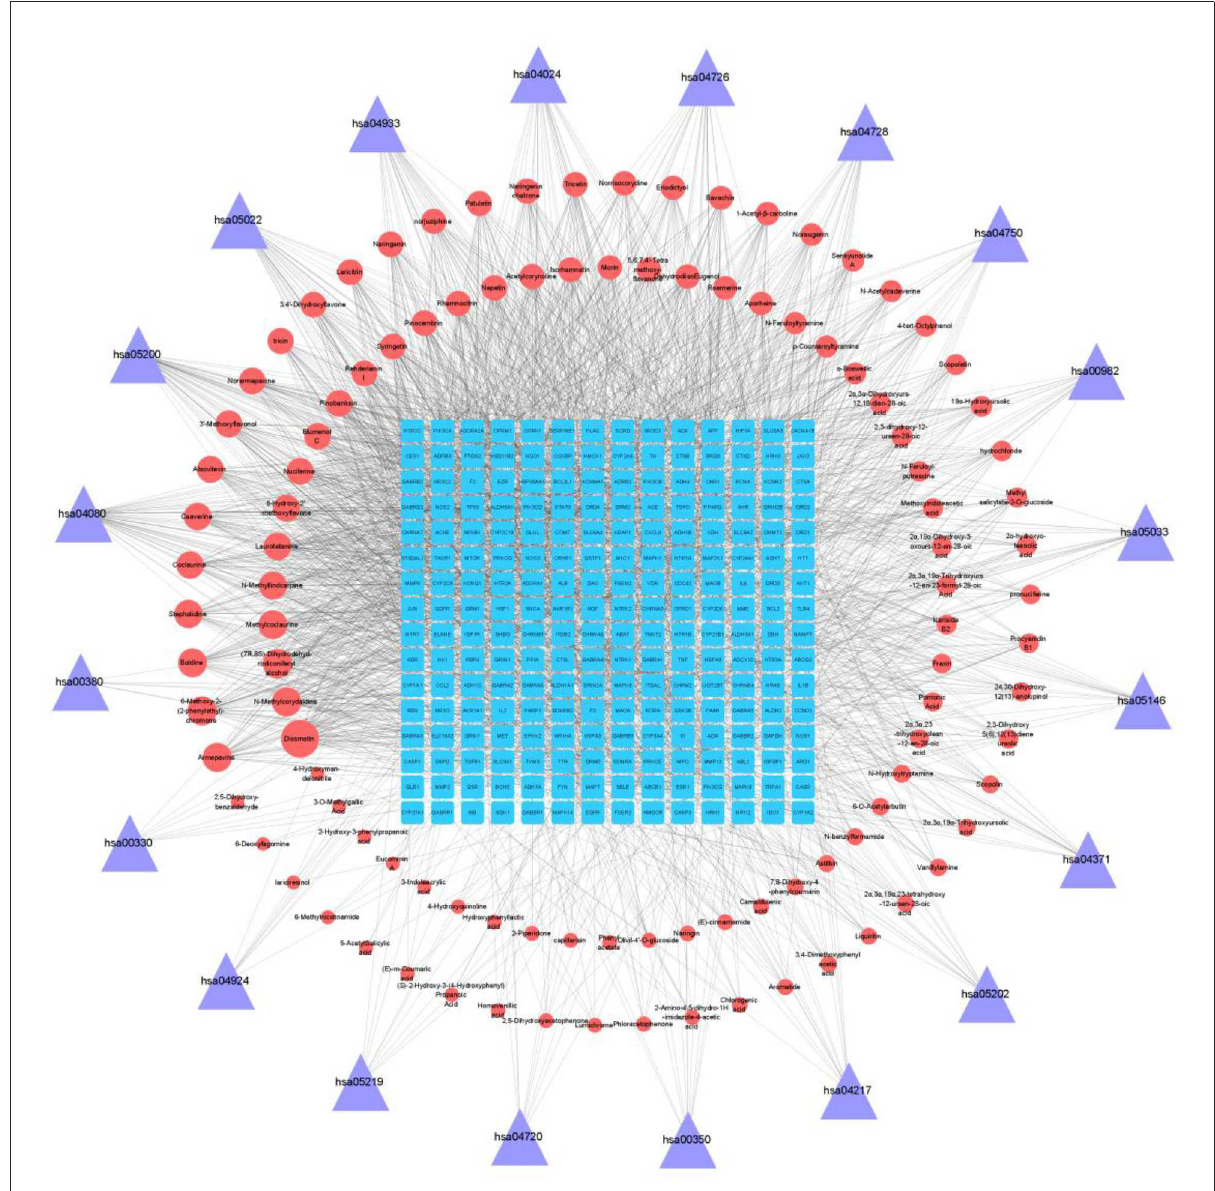
FIGURE3 Compound-target-pathway network